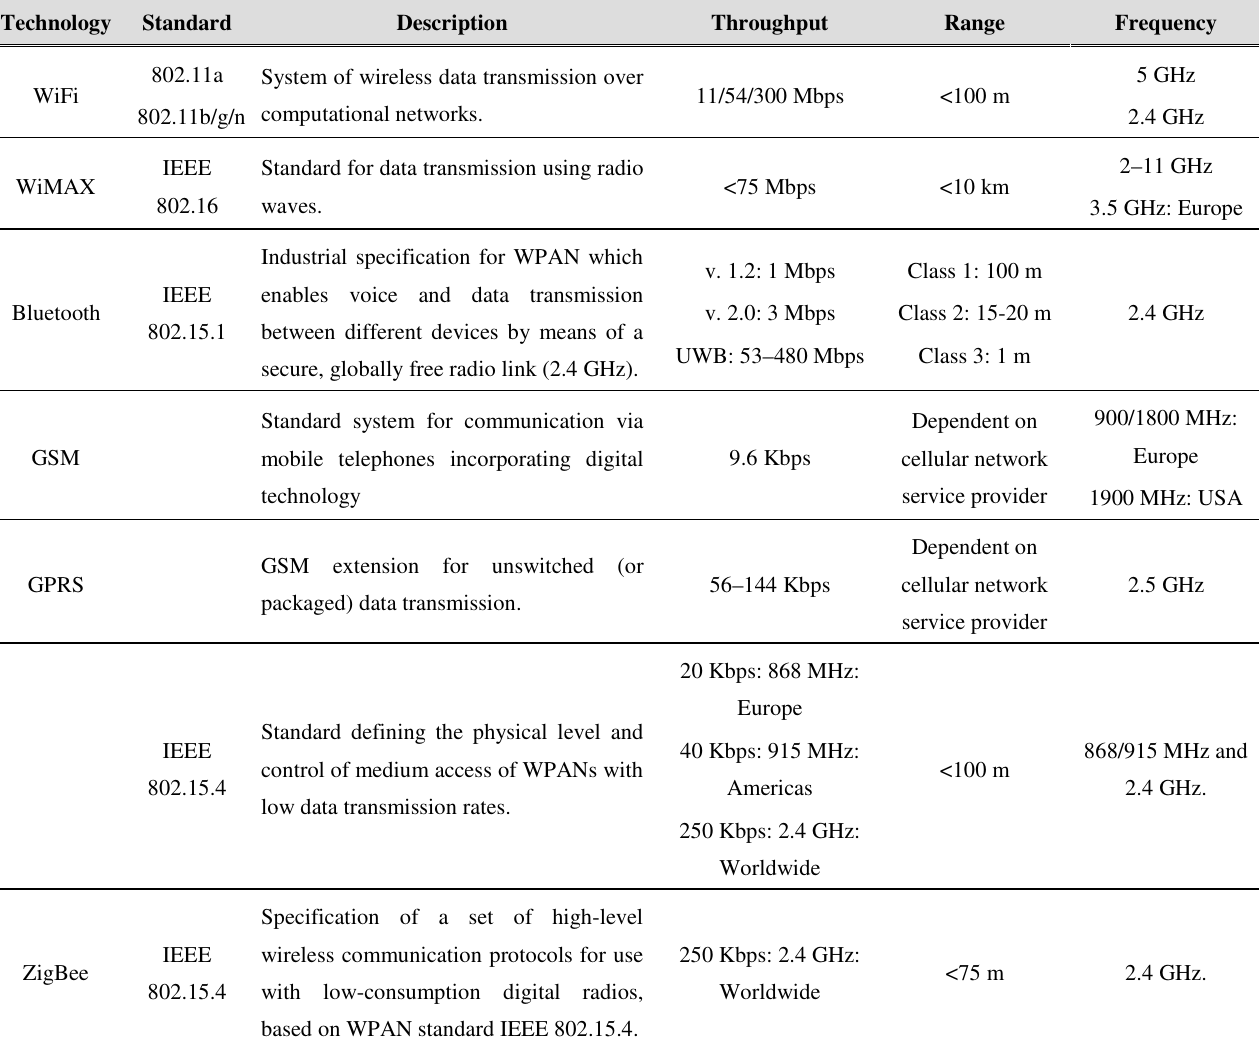
Table 1. Wireless communication